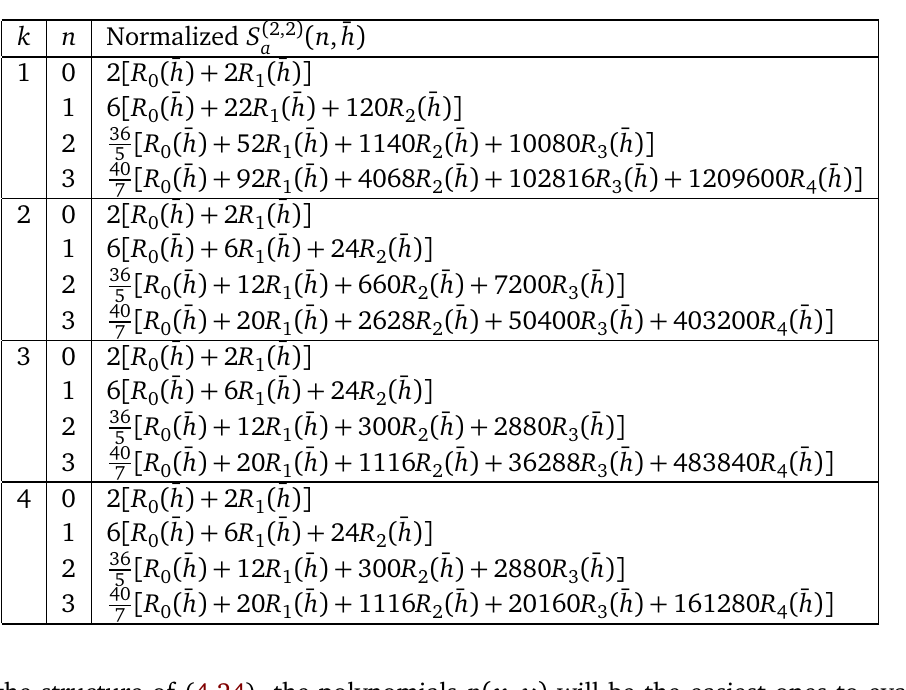
∨ ( F ) 1 ] 2 t F a which is the coefficient of the 2 | G F | ( F t ) 0 a